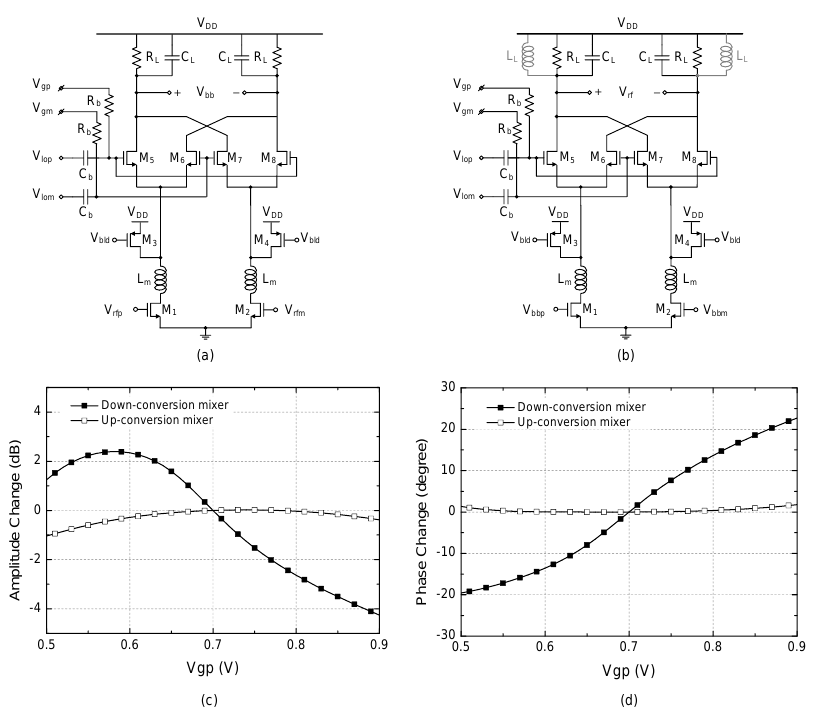
Figure 5. Effects of the gate bias control on the output phase and amplitude. ( a ) Down-conversion mixer with R L C L load; ( b ) Up-conversion mixer with L L R L C L load; ( c ) Amplitude change; ( d ) Phase change.